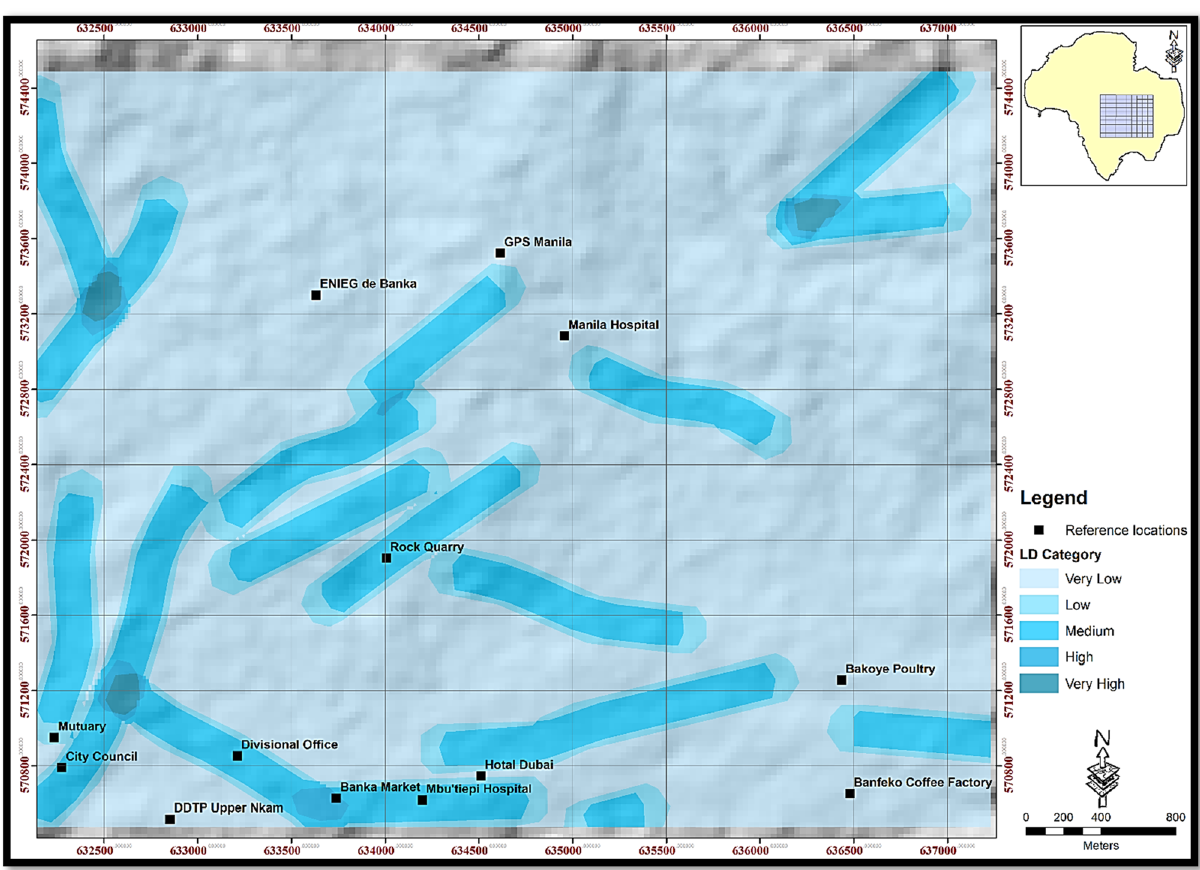
Fig. 7 Lineament density map of study area. Medium, high and very high densities mainly appear in the central, south and western parts if study